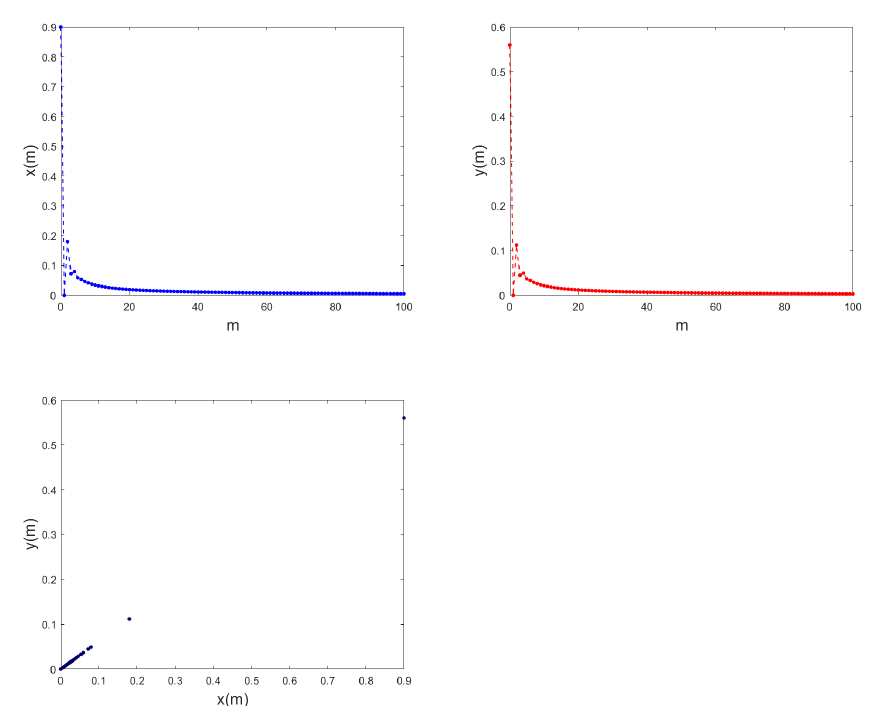
Figure 9. Time evolution of the controller fractional predator–prey discrete system of Leslie type (17) for γ = 0.8, a = 2.2, b = 5, c = 5.5, δ = 1.05 and ( x ( 0 ) , y ( 0 )) = ( 0.9,0.56 ) .